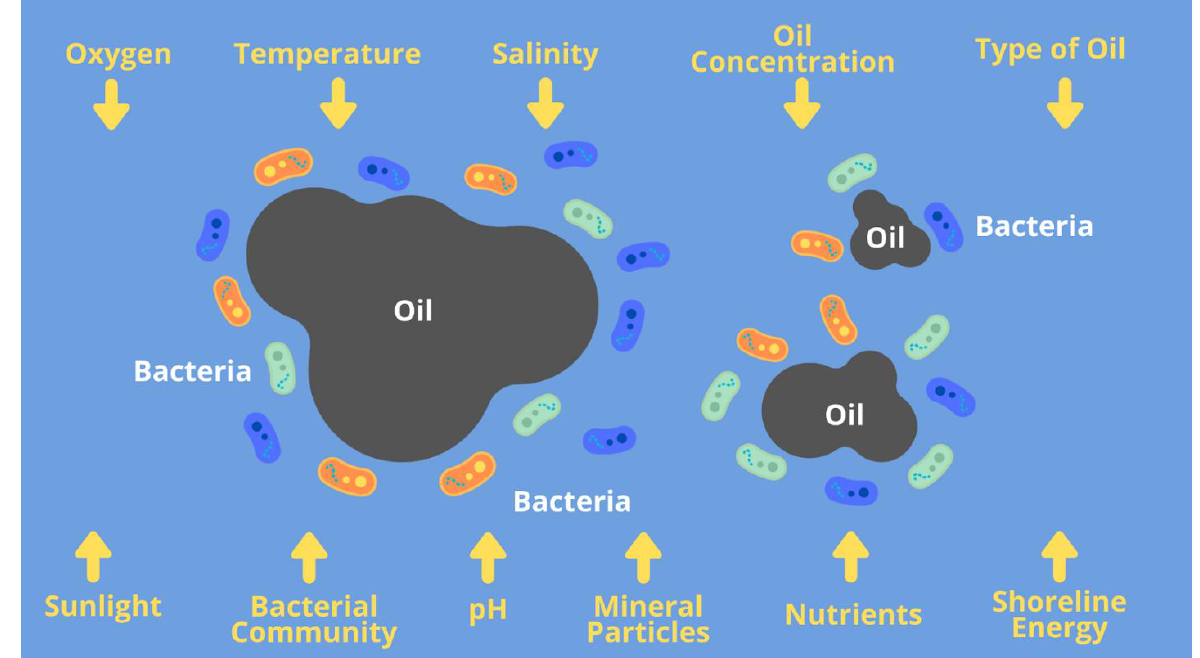
Figure 16. Factors affecting the biodegradation of oil by bacteria in seawater.